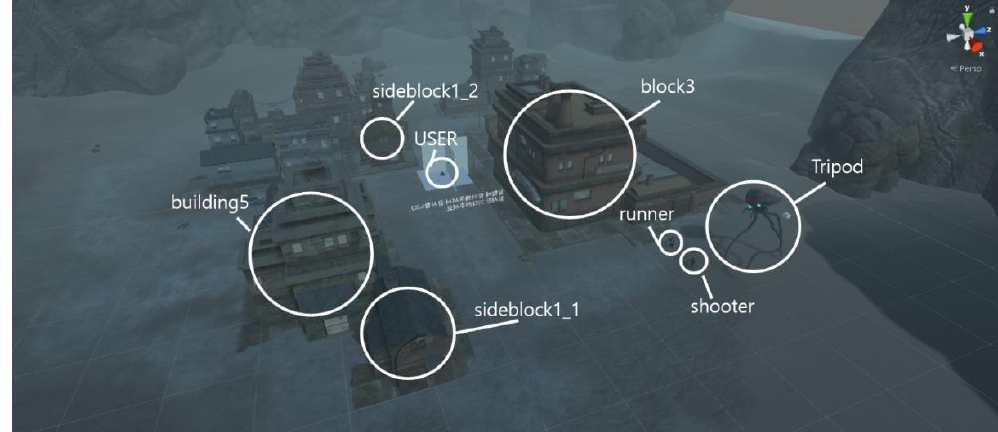
Figure 3. A snapshot of the VR environment of the story. The user sees the ending phrase in the center of the view. ‘Thank you for your participation. Please wait until the experiment ends.’